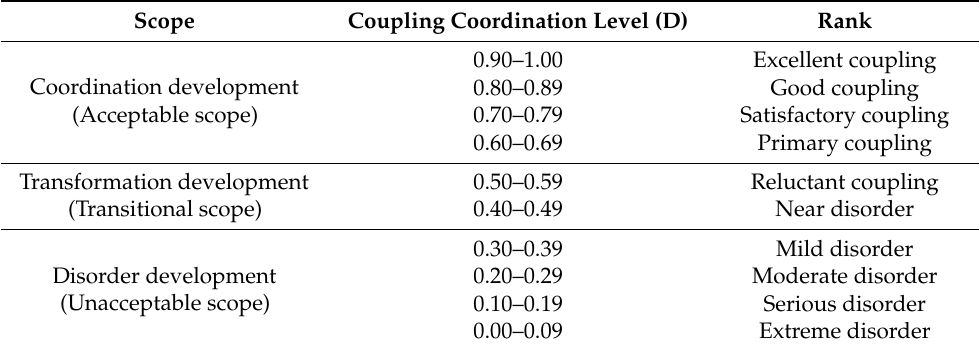
Table 1. The classification criteria of coupling coordination